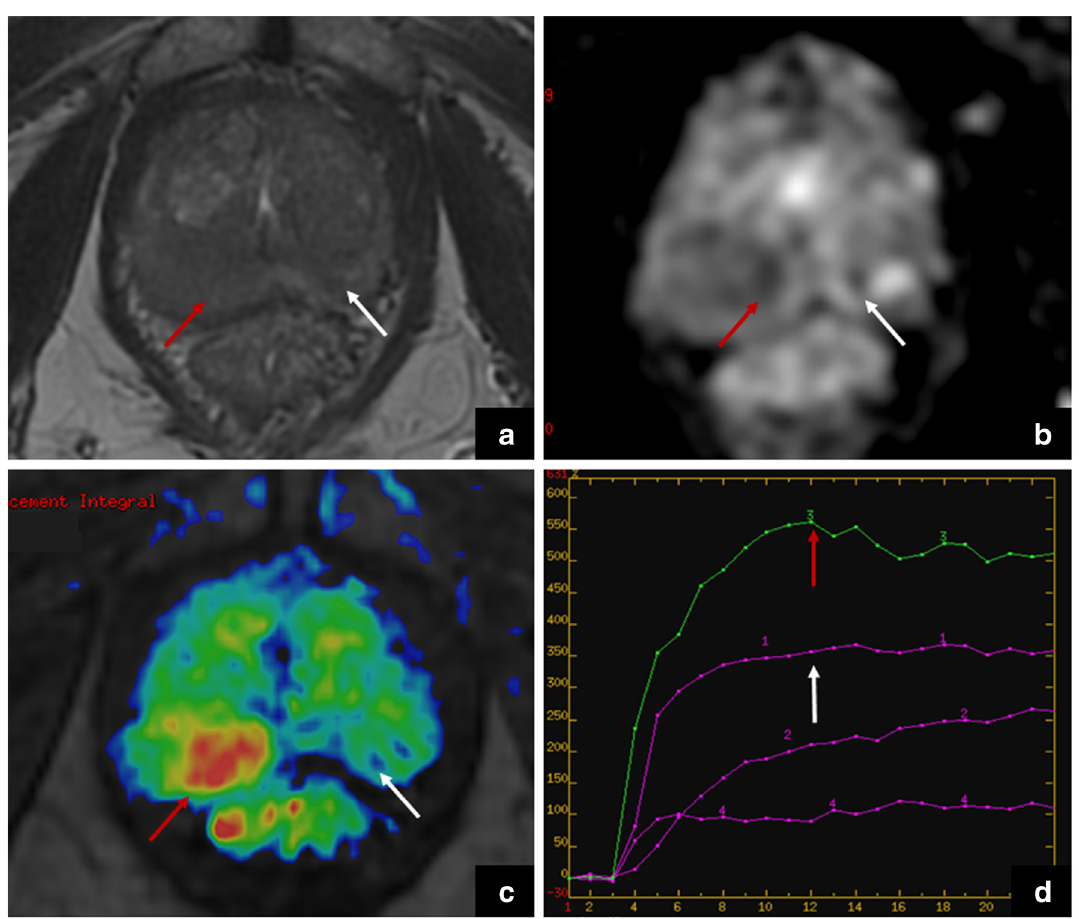
cancer (Gleason3 +3). Thewhite arrowsshowa diffuse area ofdecreased signal in the left peripheral zone on T2-weighted imaging ( a ), and a mild restrictionintheADC map ( b ) and diffuse contrast uptake ( c and d ); these findings are consistent with